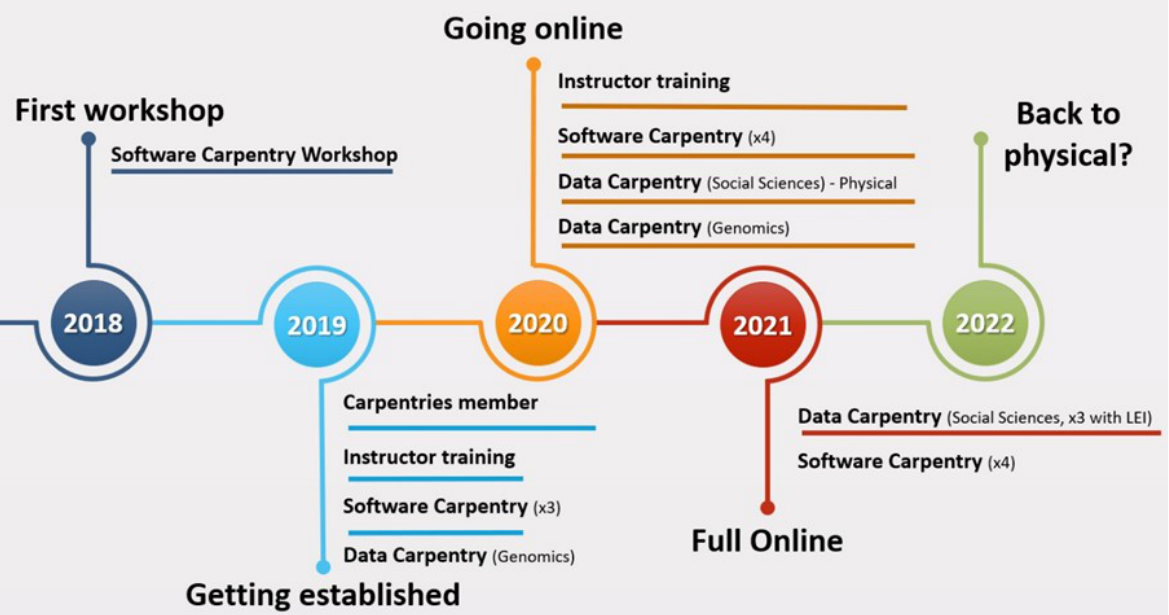
Figure 1 : Overview of the Carpentry workshops that TU Delft (co)organised from 2018 onwards. From 2020 onwards, all workshops were hosted online, with the exception of the last physical workshop (Social Science Data Carpentry). The Social Science Data Carpentries in 2021 were co - organised together with the Centre for Digital Scholarship of Leiden University Library